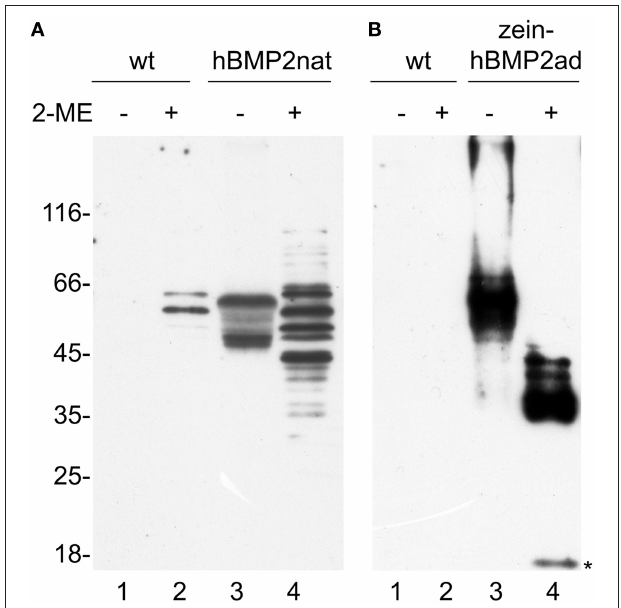
FIGURE 4 | Both hBMP2nat and zein-hBMP2ad are soluble in tobacco transgenic plants. Thirty micrograms of total leaf proteins from wild type (wt, A , lanes 1–2) and hBMP2nat line #3 ( A , lanes 3–4) plants or 3 µ g of total leaf proteins from wild type (wt, B , lanes 1–2) and zein-hBMP2ad line #7 ( B , lanes 3–4) plants, were extracted in the absence ( − ) or presence ( + ) of 2-ME and analyzed by SDS-PAGE and protein blot with anti-Flag antiserum. Asterisk: 18 kD hBMP2ad fragment. Numbers on the left indicate the positions of molecular mass markers, in kD.